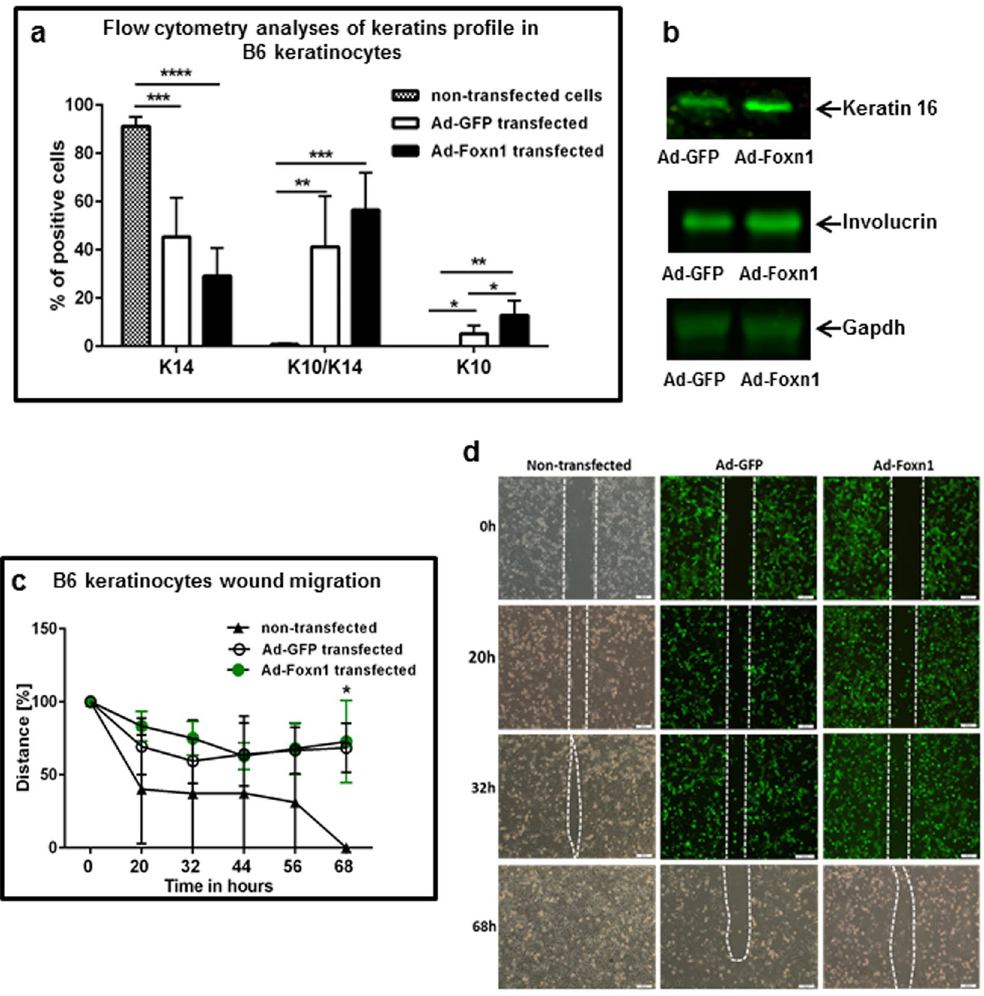
Figure 2. Foxn1 regulates keratinocyte differentiation and migration. Flow cytometric analysis of keratinocytes: non-transfected and transfected with Ad-Foxn1 or Ad-GFP, showing the percentage expressing keratin 14 (K14) only, keratin 10/keratin 14 (K10/K14) and K10 only ( a ). Representative Western blots of keratin 16 and involucrin protein expression in keratinocytes transfected with Ad-Foxn1 or Ad-GFP (control) ( b ). Full-length blots are presented in Supplementary Figure S2. Migratory abilities after pre-treatment with mitomycin C and wounding in monolayer cultures were analysed in non-transfected B6 keratinocytes and in keratinocytes transfected with Ad-Foxn1 or Ad-GFP ( c , d ). Representative images were taken at 0, 20, 32 and 68 h ( d ). Dotted lines indicate the distance between migrating keratinocytes ( d ). Migration is expressed as the percentage of the distance between the unclosed edges ( c ). Each well was prepared in duplicate, and the experiment was repeated two times (n = 11 animals). Values are the mean ± SD. Asterisks indicate significant differences ( * p < 0.05; ** p < 0.01; *** p < 0.001; **** p <